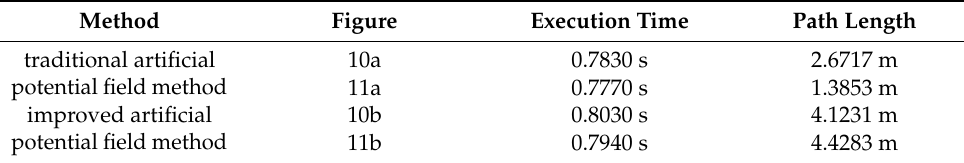
Table 4. The comparison results between the improved and traditional algorithm. Method Figure Execution Time Path Length